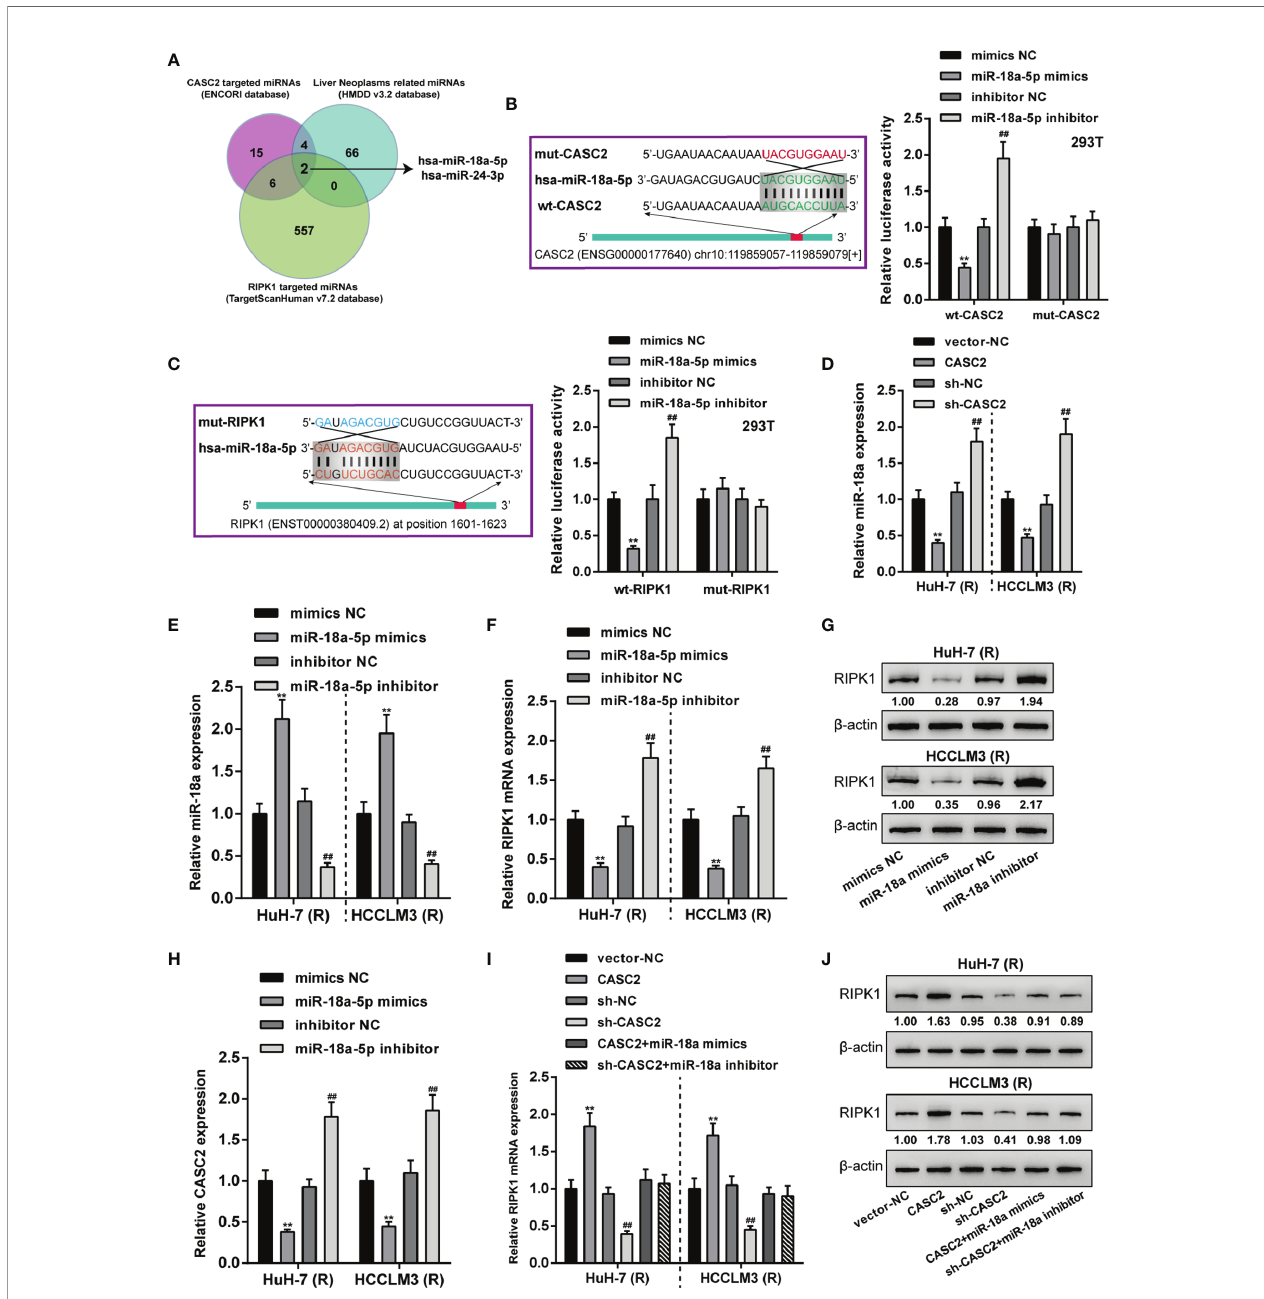
FIGURE 6 | LncRNA CASC2 targets miR-18a to modulates miR-18a downstream RIPK1. (A) ENCORI and TargetScan 7.2 were used to analyze miRNAs that might bind to CASC2 and RIPK1; HMDD v3.2 data were used to analyze miRNAs that might relate to liver neoplasms. miRNAs obtained from three tools intersected in miR-18a and miR-24-3p. (B, C) Wild- and mutant-type CASC2 and RIPK1 luciferase reporter plasmids were constructed. The predicted miR-18a binding sites in mutant-type CASC2 and RIPK1 reporter plasmids were mutated. These reporter plasmids were then co-transfected in 293T cells with miR-18a mimics or inhibitor, and the luciferase activity was determined. (D) Huh-7 (R) and HCCLM3 (R) cells were transfected with CASC2 or sh-CASC2 and examined for miR-18a expression using qRT-PCR. (E) miR-18a overexpression or inhibition was achieved in Huh-7 (R) and HCCLM3 (R) cells by transfecting miR-18a mimics or inhibitor; miR-18a expression was con fi rmed using qRT-PCR. (F – H) Huh-7 (R) and HCCLM3 (R) cells were transfected with miR-18a mimics or inhibitor and examined for RIPK1 mRNA (F) and protein (G) levels or CASC2 mRNA (H) expression using RT-PCR and Immunoblotting. (I, J) Huh-7 (R) and HCCLM3 (R) cells were transfected with CASC2 or sh-CASC2 and miR-18a mimics or inhibitor and examined for RIPK1 mRNA (I) and protein (J) levels using RT-PCR and Immunoblotting. **p < 0.01, compared with vector-NC or mimics NC group, ## p < 0.01, compared with sh-NC or inhibitor NC